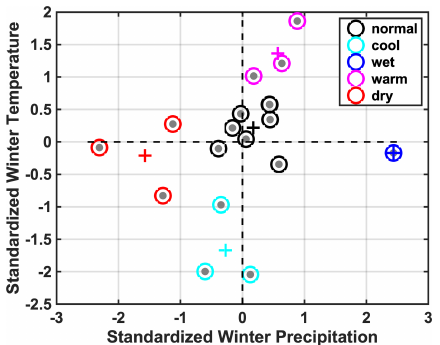
Figure 11. Category of different climate conditions from clustering analysis, based on the normalized winter precipitation and winter air temperature. Five clusters were identified as normal, wet, dry warm and cool conditions, with the centroid of each cluster marked with the “ + ”